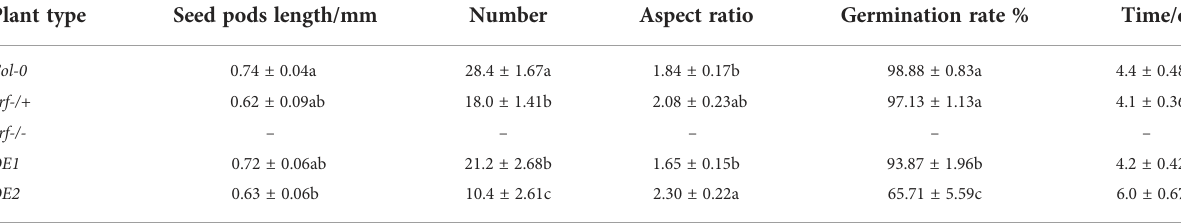
TABLE 5 Seed characteristics for different lines of A. thaliana .